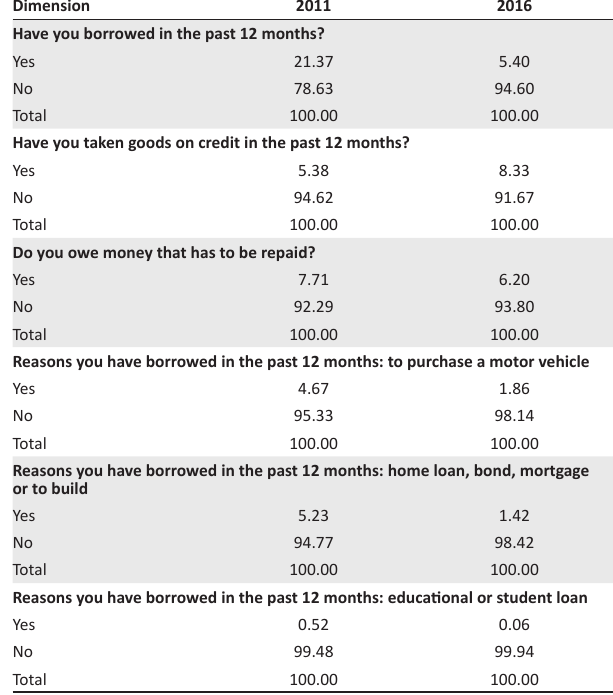
TABLE 6-A1: Description of data on the borrowing dimension of financial health ( % ). Dimension